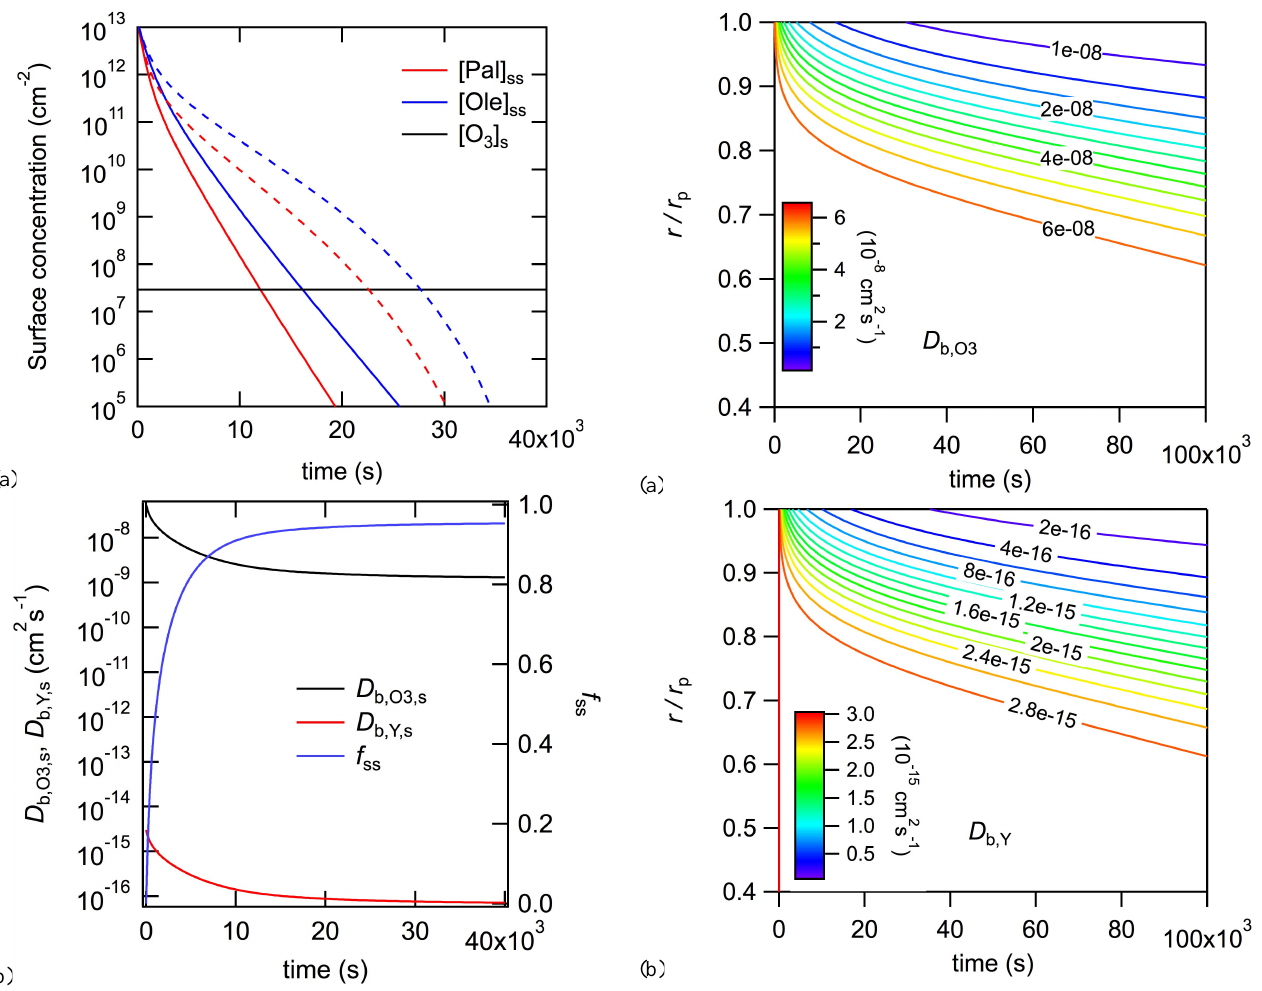
Fig. 3. (a) Time profiles of concentrations in the quasi-static sur- face layer of the reactive acids and ozone for constant-diffusivity (dashed lines) and diffusivity-evolution (solid lines) model variants. (b) Time evolution of diffusion coefficients for ozone and oleic acid as well as extent of solidification ( f ss ) at the particle surface for the diffusivity-evolution model variant.